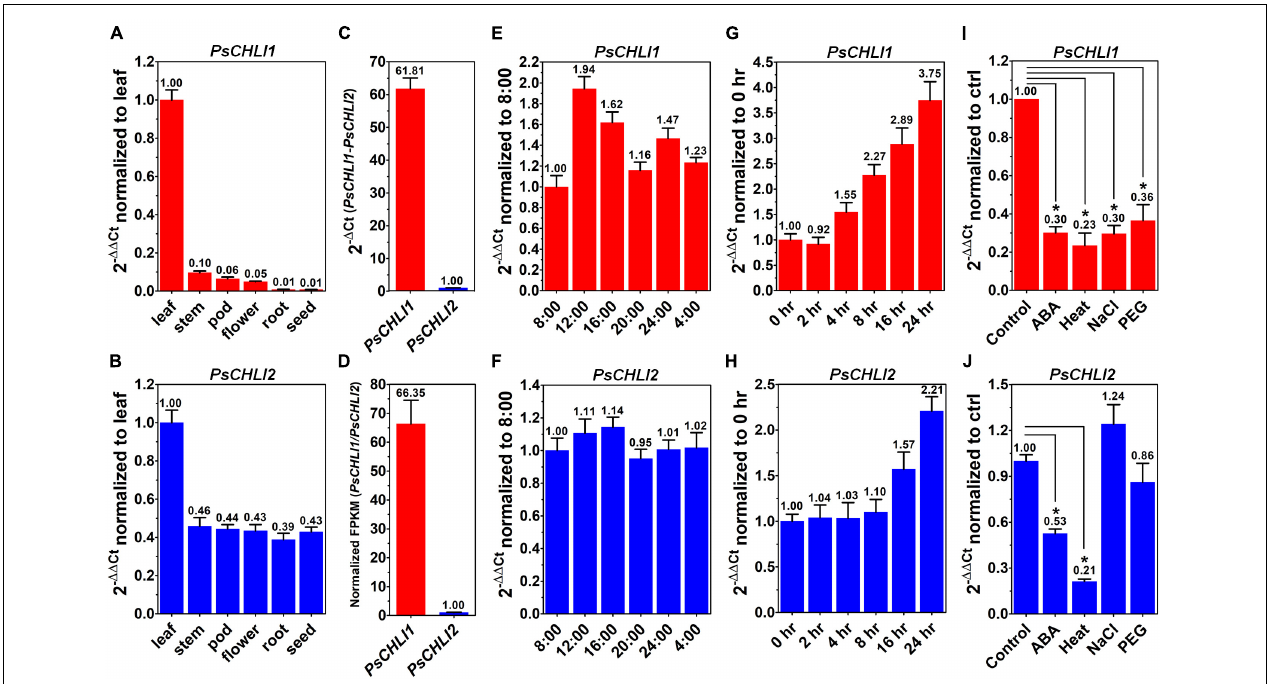
FIGURE 2 | Expression profiles of PsCHLI1 and PsCHLI2 . The expression of PsCHLI1 and PsCHLI2 in different organs (A,B) , time points (E,F) , irradiation times (G,H) , abscisic acid (ABA, I,J ), and abiotic stresses (heat, NaCl, and PEG6000, I,J ) were examined by quantitative real-time PCR (qPCR). The expression level of PsCHLI1 and PsCHLI2 was compared by qPCR (C) and RNA sequencing (D) . The 2 − (cid:49)(cid:49) Ct method was used to calculate the relative expression for qPCR. The transcript levels were quantitatively normalized to the transcript level of pea EF-1 α . Gene expression levels for RNA sequencing were estimated by fragments per kilobase of transcript per million fragments mapped (FPKM). Error bars indicate the standard error of the mean (SEM) from three biological replicates, * P < 0.05, one-way analysis of variance.